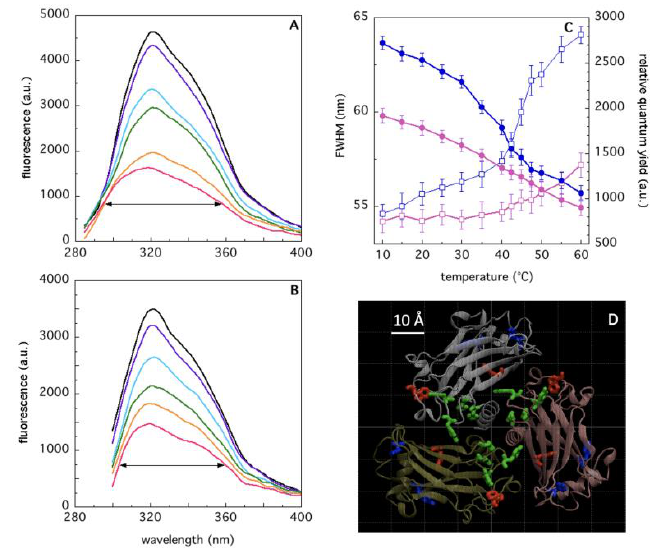
Figure 4. Fluorescence spectra of TRAF2-C as a function of temperature (10 ◦ C, black; 20 ◦ C, purple; 35 ◦ C, cyan; 40 ◦ C, green; 50 ◦ C, orange; 60 ◦ C, red) upon excitation at 275 nm (panel ( A )) and 292 nm (panel ( B )). The relative fluorescence quantum yield (i.e., the total spectral area) and the full width at half maximum (FWHM), black horizontal arrows, panels ( A , B )) are reported as a function of temperature in panel ( C ) ( λ ex = 275, blue lines; λ ex = 292, red lines; filled symbols, quantum yield; empty symbol, FWHM). The position of the TRP residues (W356, W424 in red), of the TYRs close to the monomers interfaces (Y350, Y382, Y386, Y388, in green) and of TYRs located in the protein peripheral area (Y395, Y484, in blue) are reported in panel ( D ), in which a top view of trimeric TRAF2-C is shown.